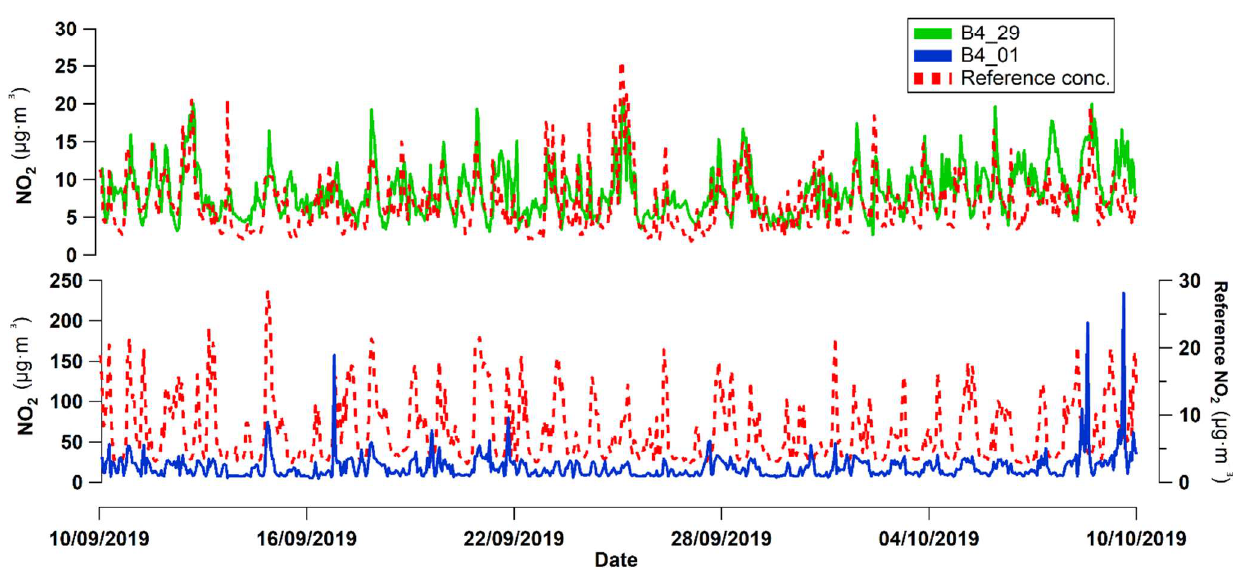
Figure 11. Time series of the 1-h average concentrations of SO 2 and NO 2 measured in the test cam-